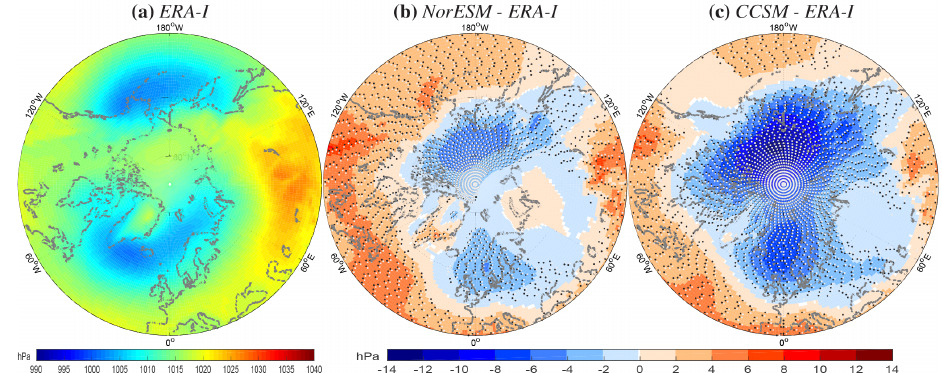
Figure 6. Sea level pressure average for SOND 1979–2005 in (a) ERA-I and bias of (b) NorESM and (c) CCSM compared to ERA-I. Alternating black and white dots in panels (b) and (c) mark regions of significant bias at a 95% confidence level. Table 2. Time period mean sea level pressure (SLP), track density (tden), mean intensity (mint) and precipitation ( P ) SOND averages for 1979–2005 (1979–2005) and changes for 2074–2100 relative to 1979–2005 following the RCP8.5 scenario ( (cid:49) 2074–2100) in ERA-I, NorESM and CCSM. First number within each column denotes average over midlatitudes (40–65 ◦ N); second number within each column denotes average over high latitudes (65–90 ◦ N). For 1979–2005, units are hPa, no. dens (month) − 1 (10 6 km 2 ) − 1 , 10 − 5 s − 1 and mmd − 1 for SLP, tden, mint and P , respectively. For (cid:49) 2074–2100, unit is %. Data set Time period SLP tden mint P ERA-I 1979–2005 1015 NorESM